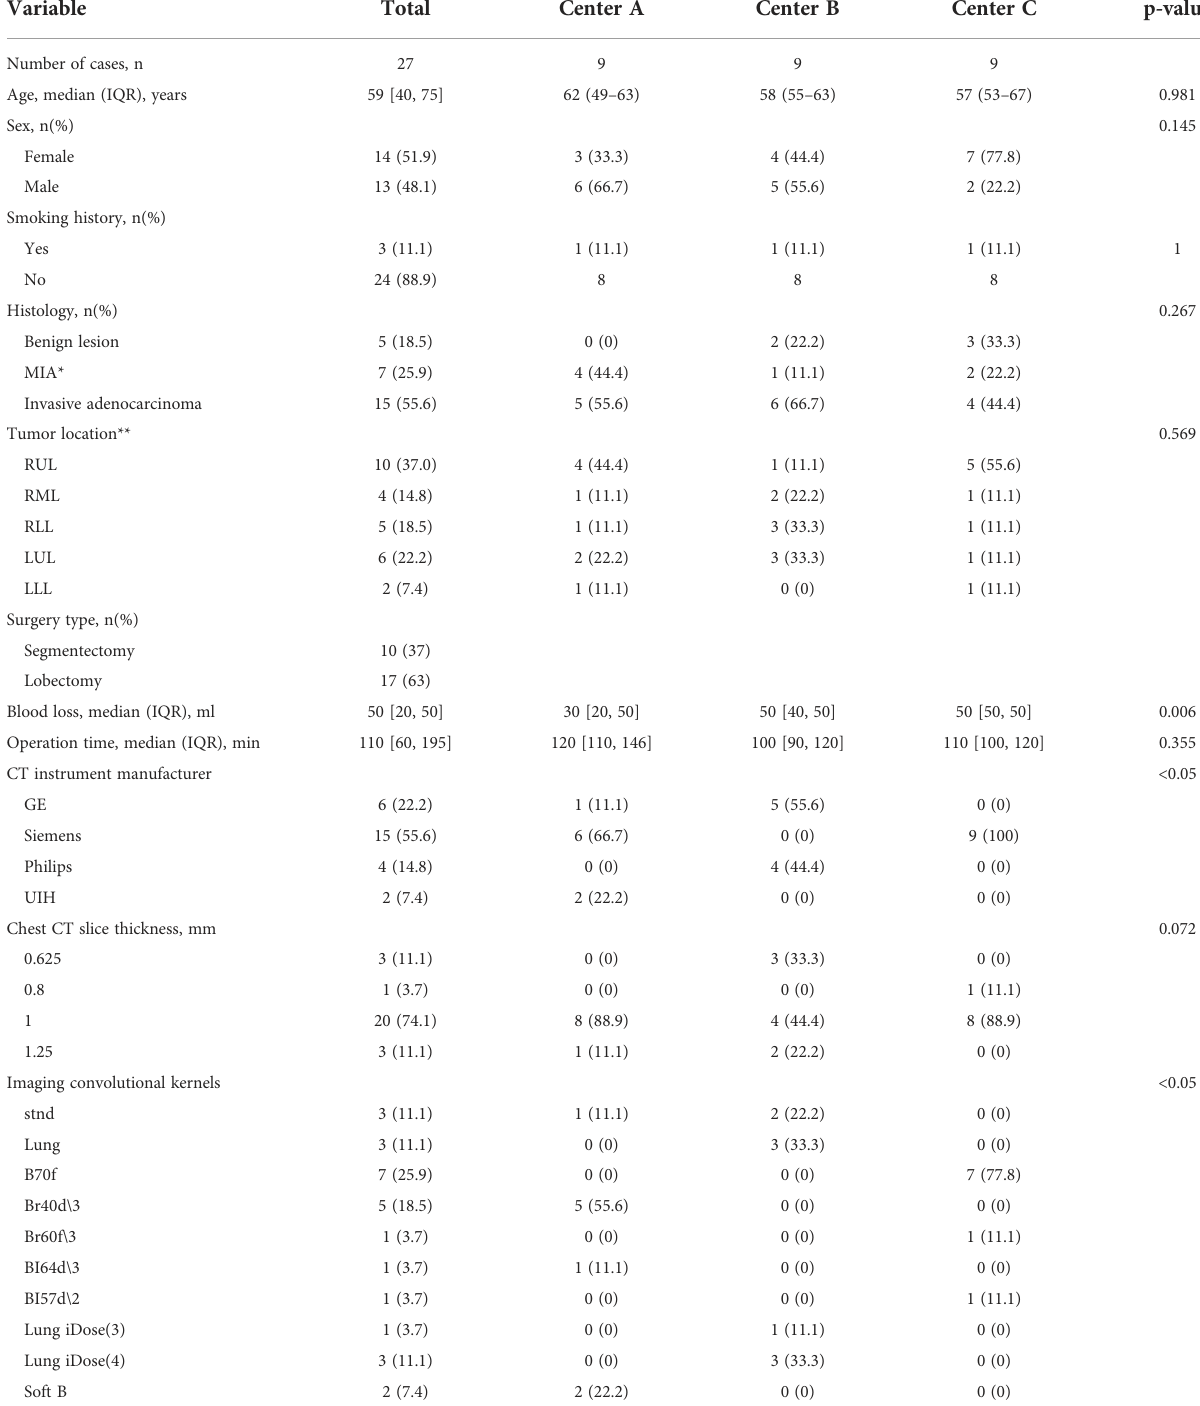
TABLE 1 Clinical characteristics of the validation